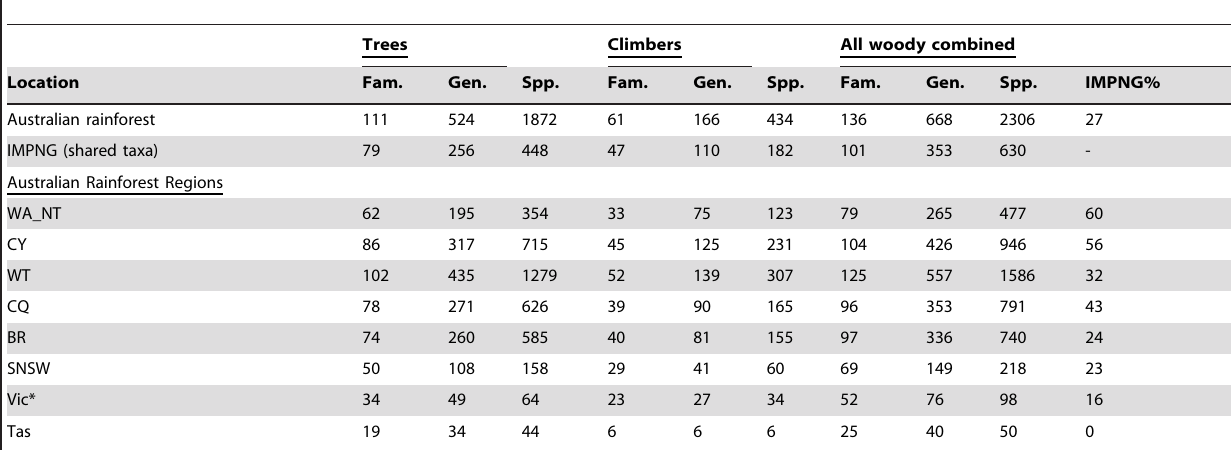
Table 1. Number of woody rainforest families, genera and species by region in continental Australia including in-shore islands.